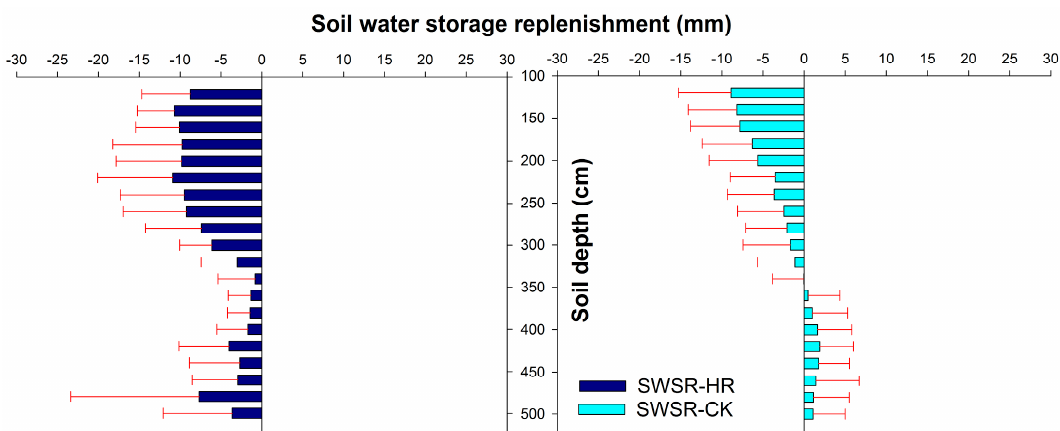
Figure 4. SWSR within deep profile during the growing season.